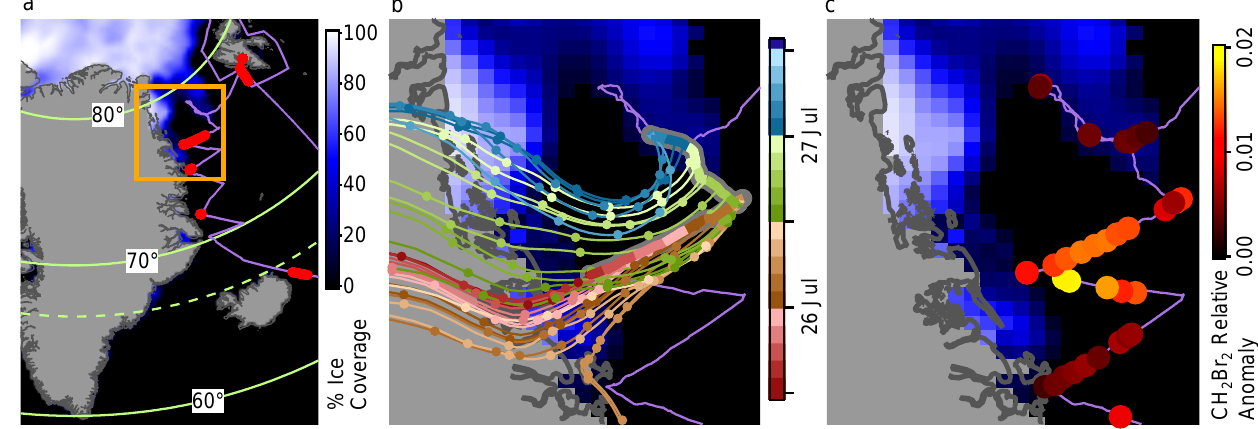
Figure 1. (a) Cruise track (purple), ice coverage and locations of NPF events (red), defined by the presence of a mode of particles smaller than 10nm not attributable to combustion or ship emissions (parts of the cruise outside of the area depicted did not show evidence of NPF). (b) HYSPLIT back trajectories from cruise track corresponding to the 25–27 July case study. Markers are at 6-hourly intervals. (c) Ratio of atmospheric concentrations of CH 2 Br 2 (a product of ice diatom activity) to its saturation levels in